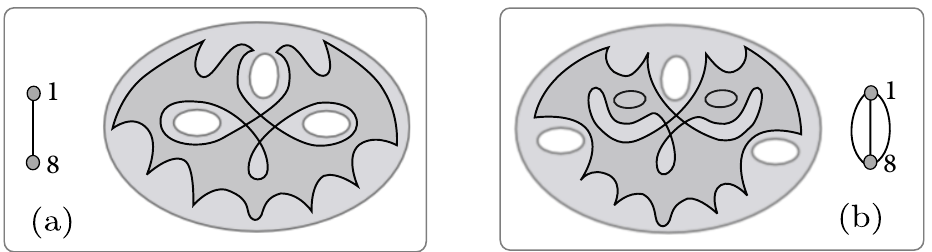
Figure 2. Example of apparent contours of stable maps to the 9-torus and its weighted graph: ( a ) corresponds to a graph type G ( 2,1,9 ) . The singular curve has eight cusp points and four double points; ( b ) corresponds to a graph type G ( 2,3,9 ) with three singular curves.